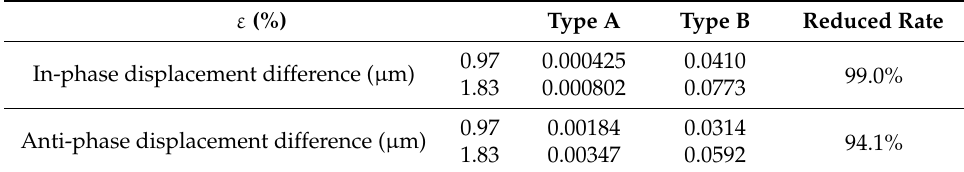
Table 5. Comparisons of displacement difference in analytical values of Type A and Type B.